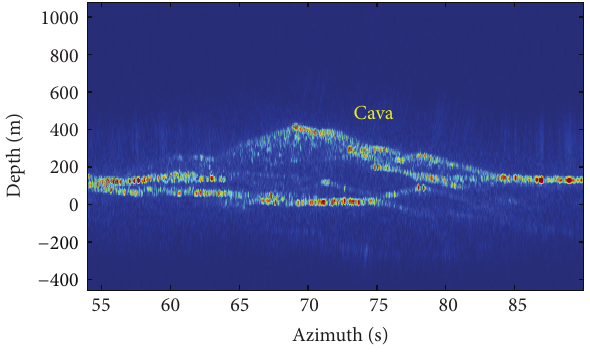
Figure 15: Obtained radargram on the Roccamonfina site (South Italy).